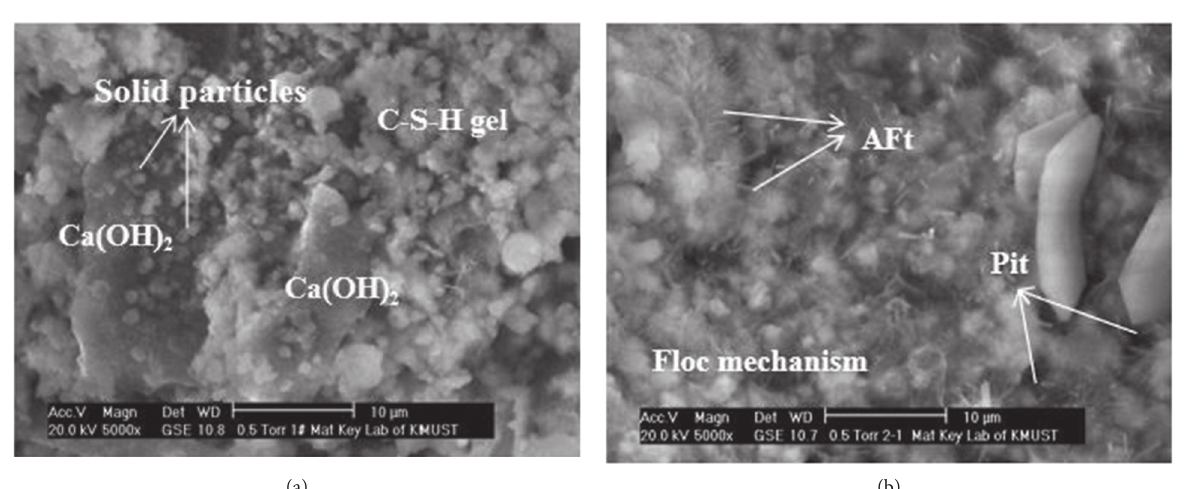
Figure 4: Microstructure of cementite after 3 days and 28 days when fly ash content is 50% without activator. (a) 3 d curing period; (b) 28d curing